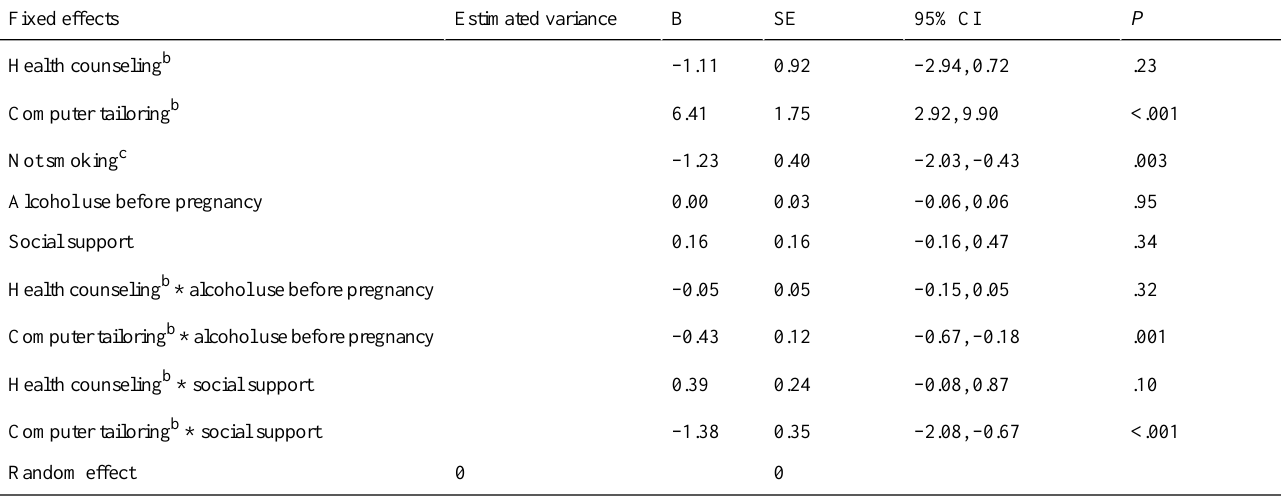
Table 3. Final model of the multilevel multiple linear regression analysis with the natural logarithm of average alcohol consumption at T2 as outcome variable among alcohol users only (N=73).